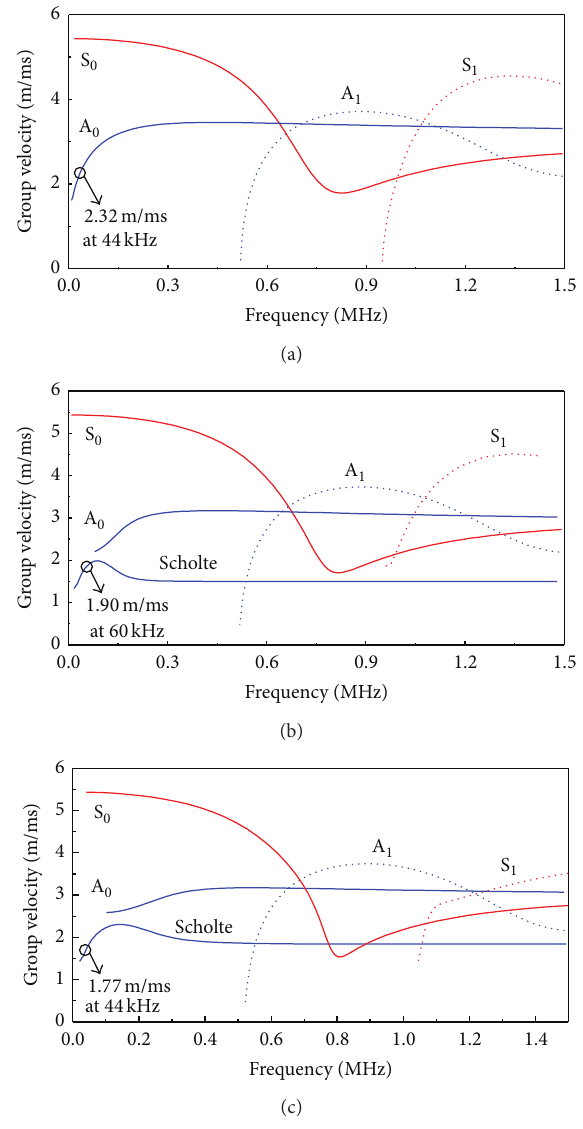
Figure2:Groupvelocitydispersioncurvesof3 mmthickaluminum plate: (a) free plate, (b) immersed in water, and (c) immersed in